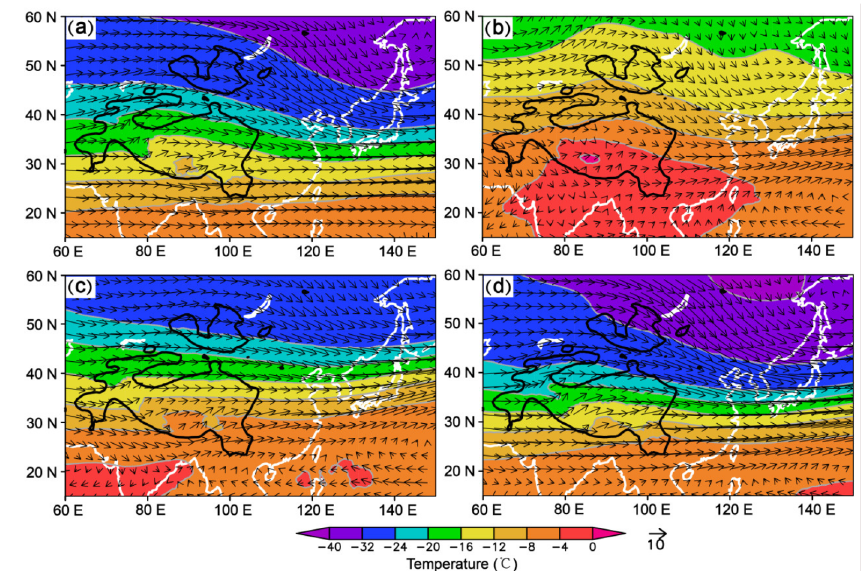
Figure 9. Vertical cross-sections of the vorticity differences (solid and dashed lines are, respectively, for the vorticity contours of 0.2 × 10 − 5 and − 0.2 × 10 − 5 s − 1 ), horizontal wind vector differences, and the longitudinal anomalies of the geopotential height difference (shaded; units: gpm) between the ECMWF-predicted and the reanalyzed along the straight lines shown in Figure 8a–d. The “A” and “C” in each panel of ( a – d ) are, respectively, for the anticyclonic and cyclonic center marked in Figure 8a–d. The mountain area of southeastern Qinghai-Tibet Plateau is grey-shaded.